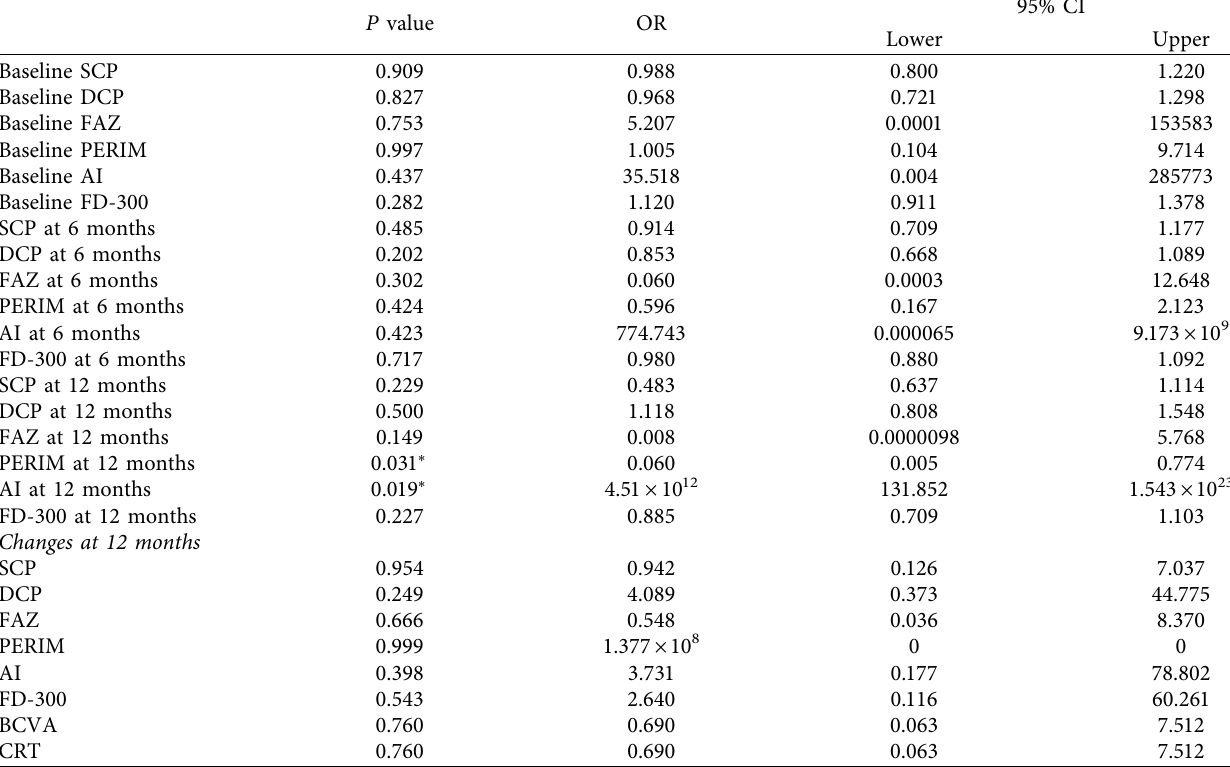
Table 7: Correlations between the evaluated parameters and the number of injections within 12